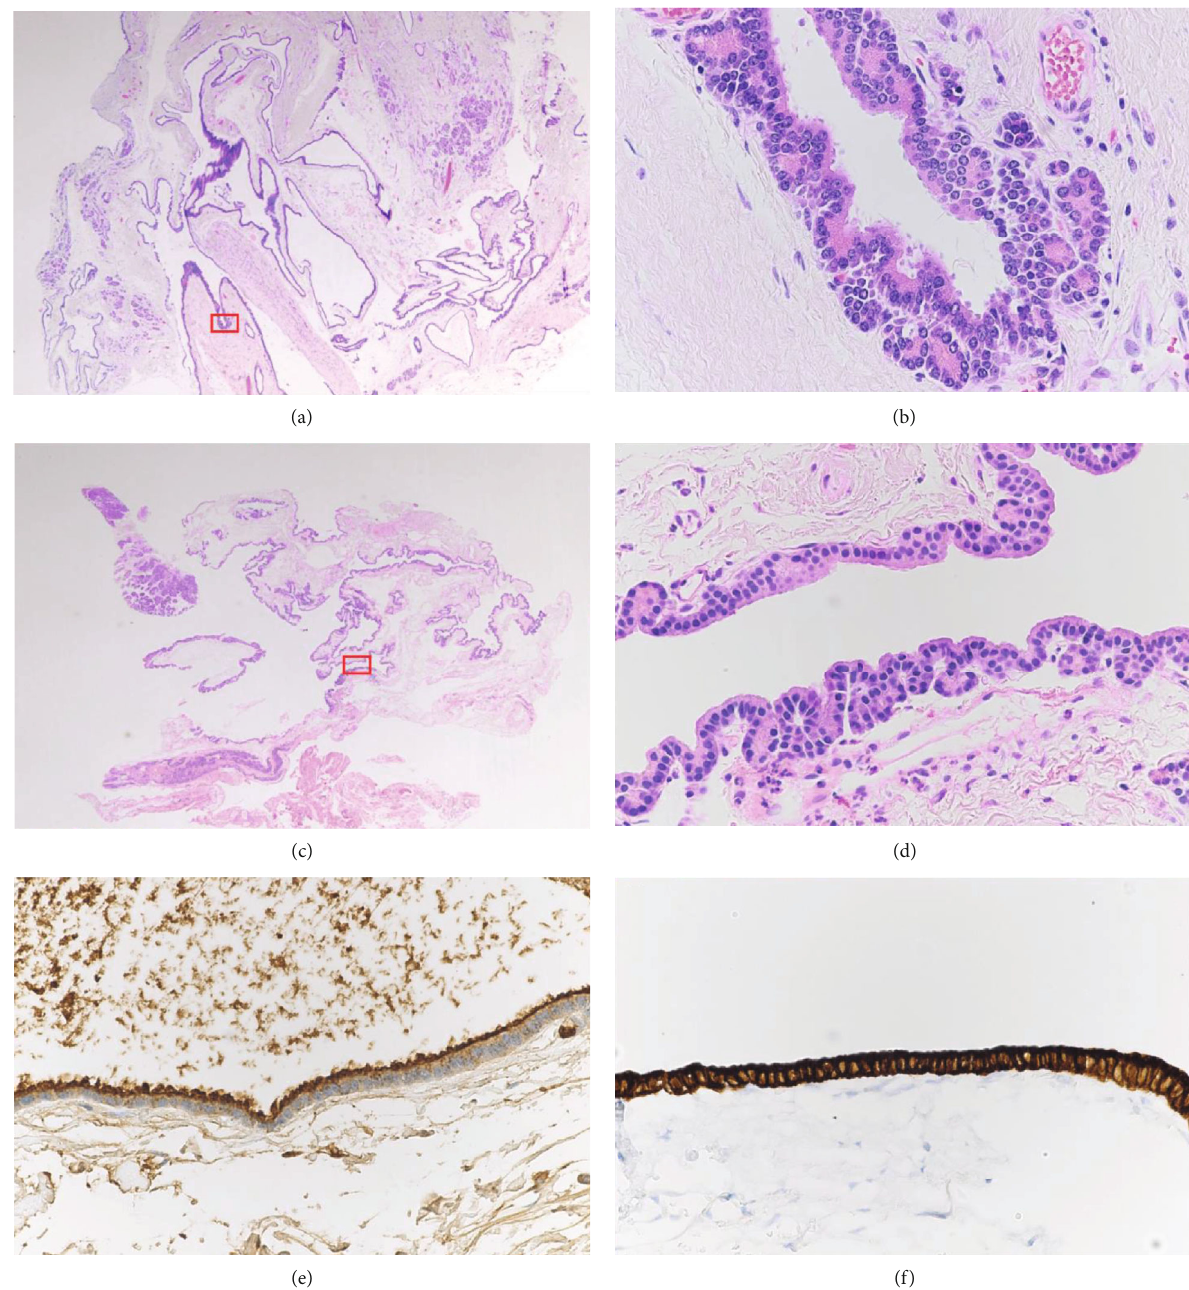
Figure 3: Microscopic images of ACT. Boxed areas are shown in a higher magni fi cation on the right side of the corresponding picture. (a) ACT in the resection specimen consists of multiple variable-sized cysts (H&E, 20x magni fi cation). (b) The lesion is lined by cells with acinar di ff erentiation which have apical eosinophilic cytoplasmic granules and uniform nuclei. Cytologic atypia and mitotic fi gures are absent (H&E, 400x magni fi cation). (c) Prior intraoperative biopsy of the cyst wall (H&E, 20x magni fi cation). (d) The prior intraoperative biopsy shows similar epithelial lining to that seen in the resection specimen (H&E, 400x magni fi cation). (e) The lining cells have coarsely granular apical cytoplasmic staining for trypsin (400x magni fi cation). (f) The lining cells have strong and di ff use cytoplasmic staining for CK7 (400x magni fi